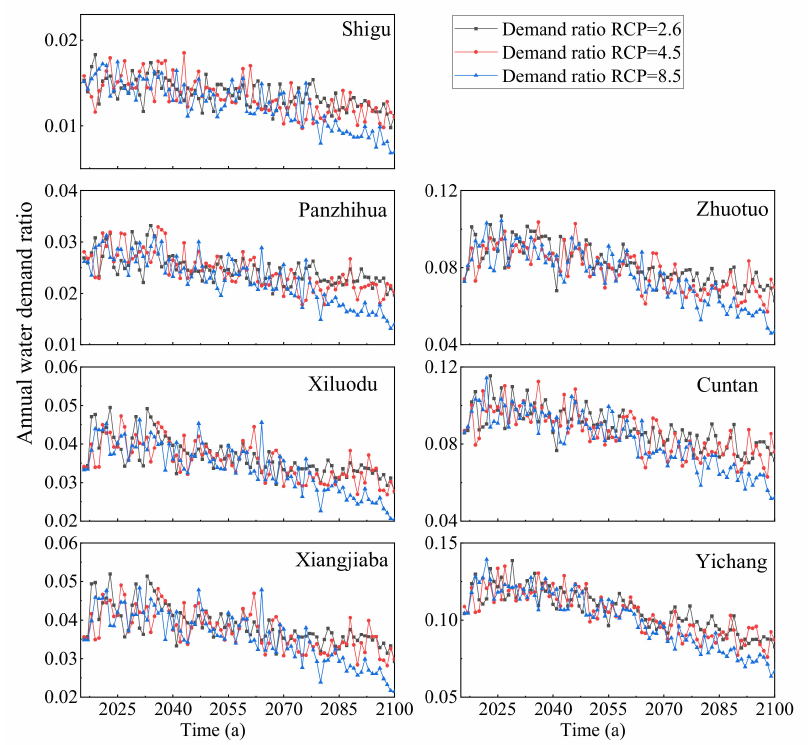
Figure 18. Annual water demand ratio above control